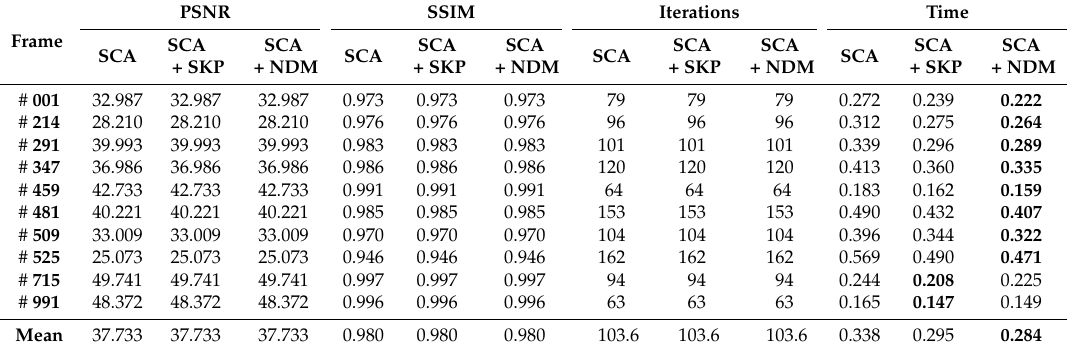
Table A1. Quantitative evaluation results for comparing internal algorithms of the ACA-based method with von Neumann neighborhood system on the selected Tsukuba Stereo Dataset. The best performance is highlighted in bold.